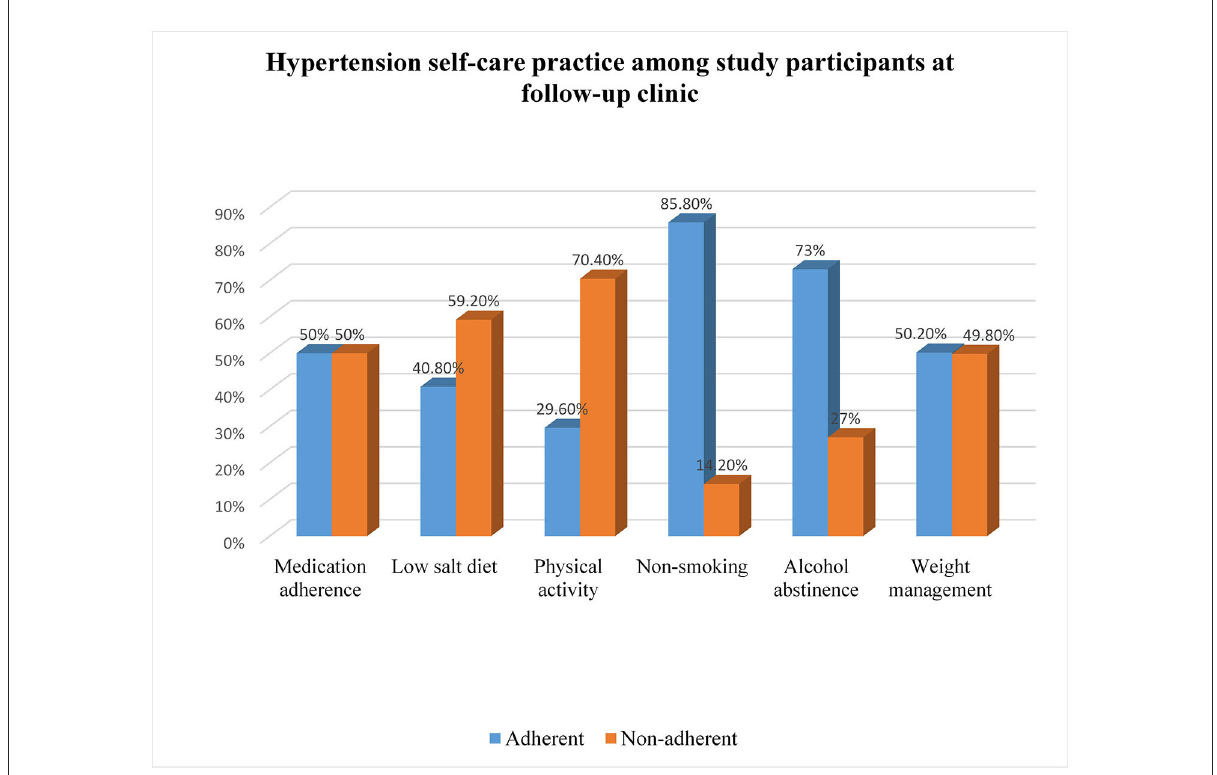
FIGURE1 Hypertension self-care practices of hypertensive patients on follow-up at public Hospitals in the Harari regional state and Dire Dawa City administration, Eastern Ethiopia, 2022 ( n =